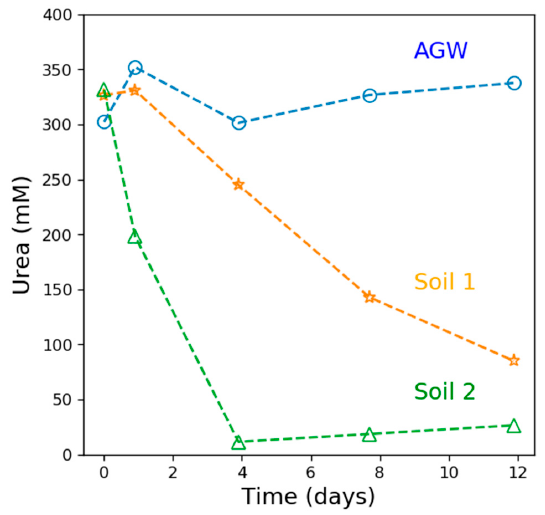
Figure 4. Urea concentrations measured in precipitation experiments following bacterial stimulation in soils from the Rotem Plateau.